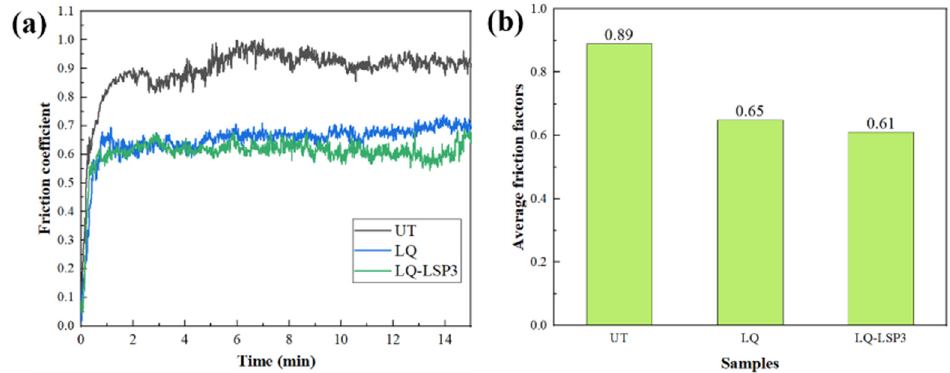
Figure 16 . ( a ) Friction coefficient; ( b ) average friction factors. Figure 16. ( a ) Friction coefficient; ( b ) average friction factors.